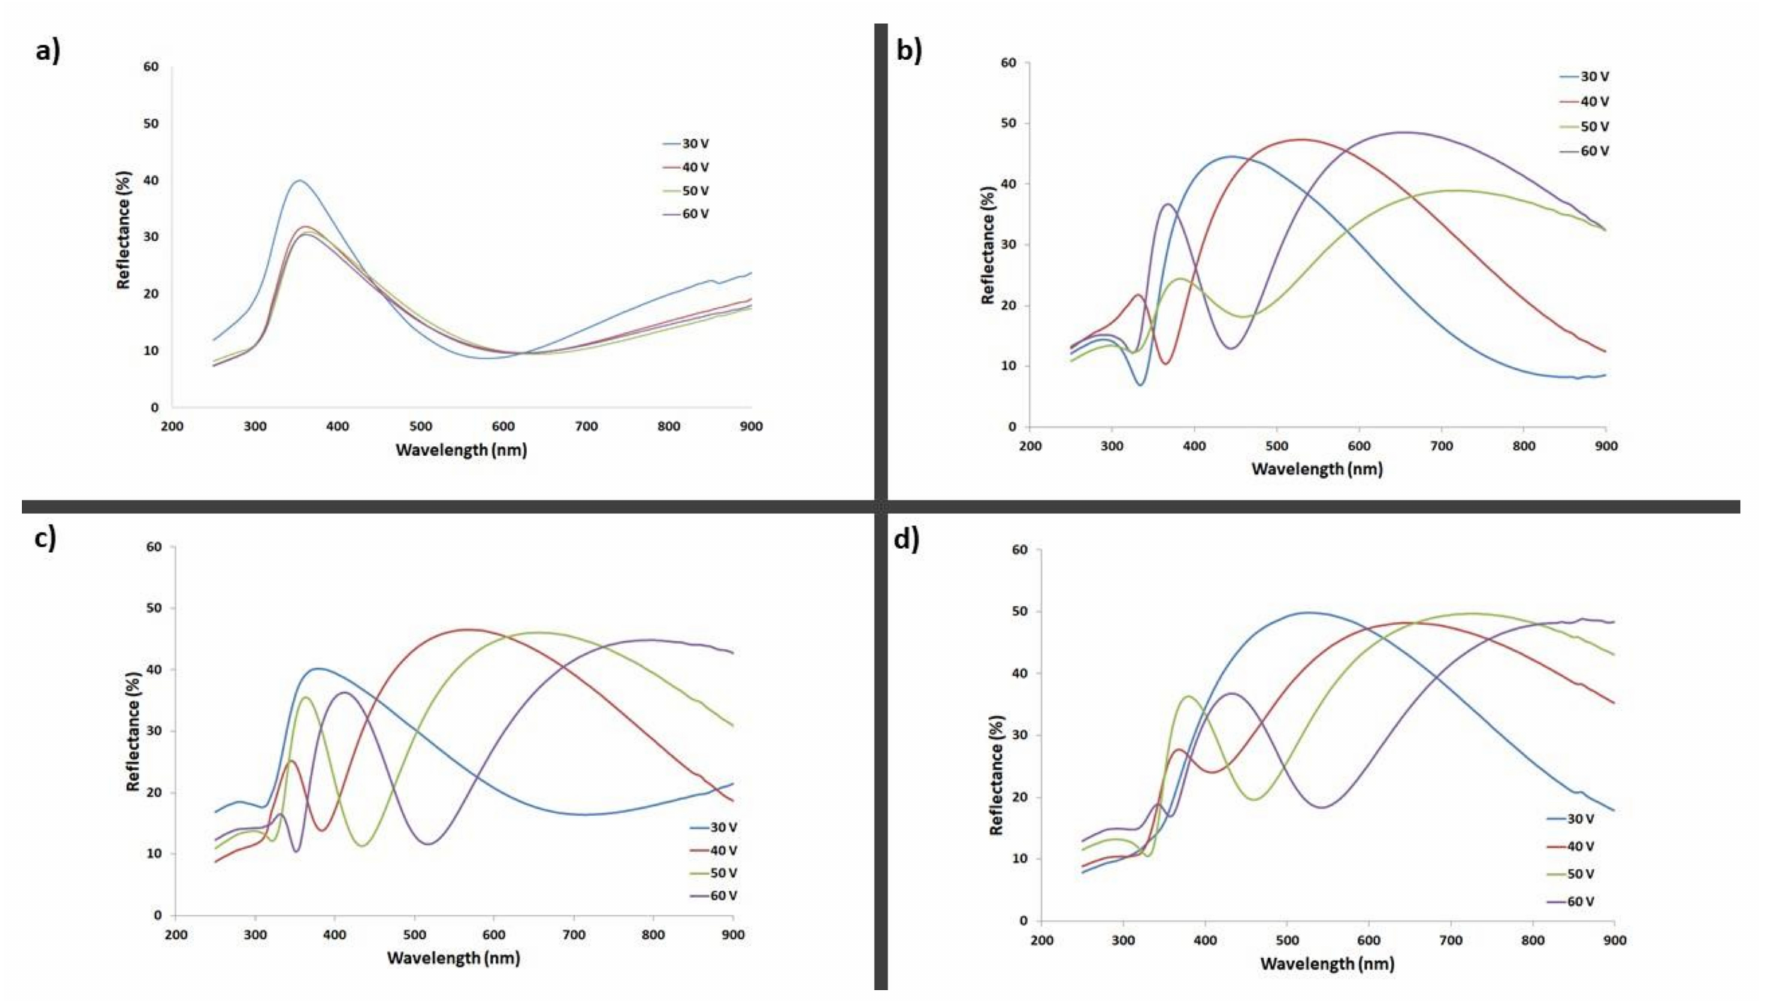
Figure 7. Diffusive reflectance plots for titanium anodic oxides formed in ethanol-based electrolytes with ( a ) 2 vol% of H 2 O; ( b ) 3.5 vol% of H 2 O; ( c ) 5 vol% of H 2 O; and ( d ) 10 vol% of H 2